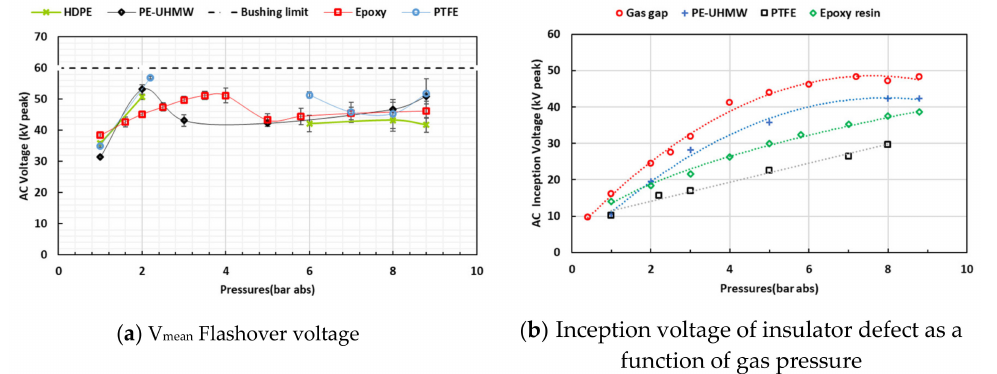
Figure 16. (4%Novec TM 4710 / 96%CO 2 , HDPE Vs PE-UHMW Vs Epoxy 2 (R a = 5 µ m) Vs PTFE, Needle on HV